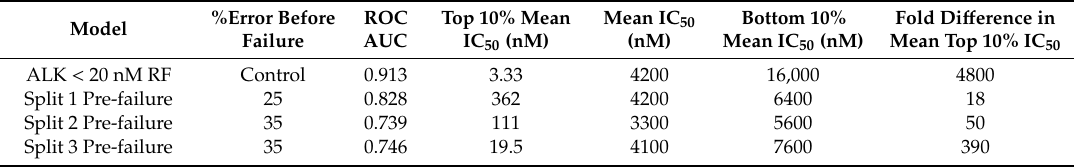
Table 6. Performance statistics for RFs with retained predictivity generated with the specified error in each